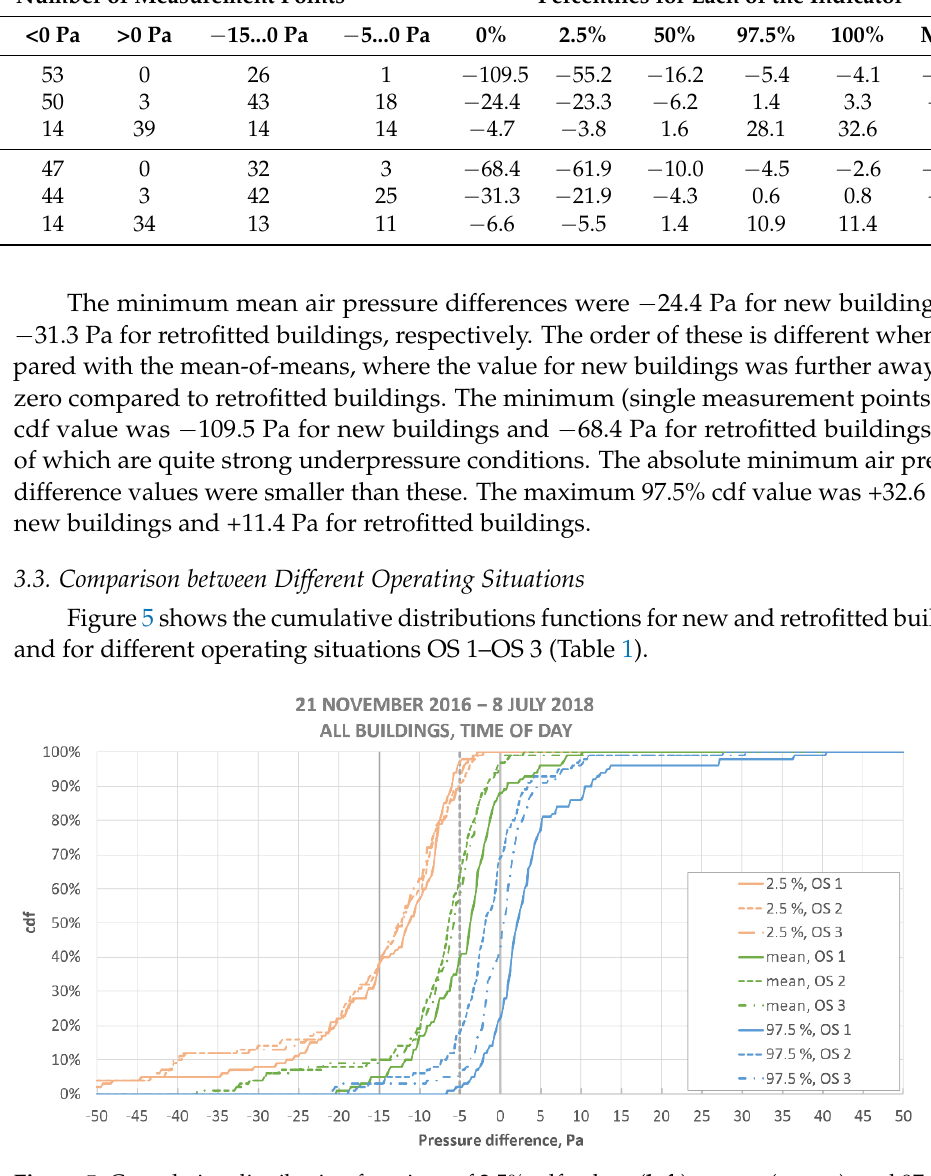
Figure 5. Cumulative distribution functions of 2.5% cdf values ( left ), means ( center ), and 97.5% cdf values ( right ) for three operating situations (OS). The bolded vertical lines indicate guideline values for air pressure differences.